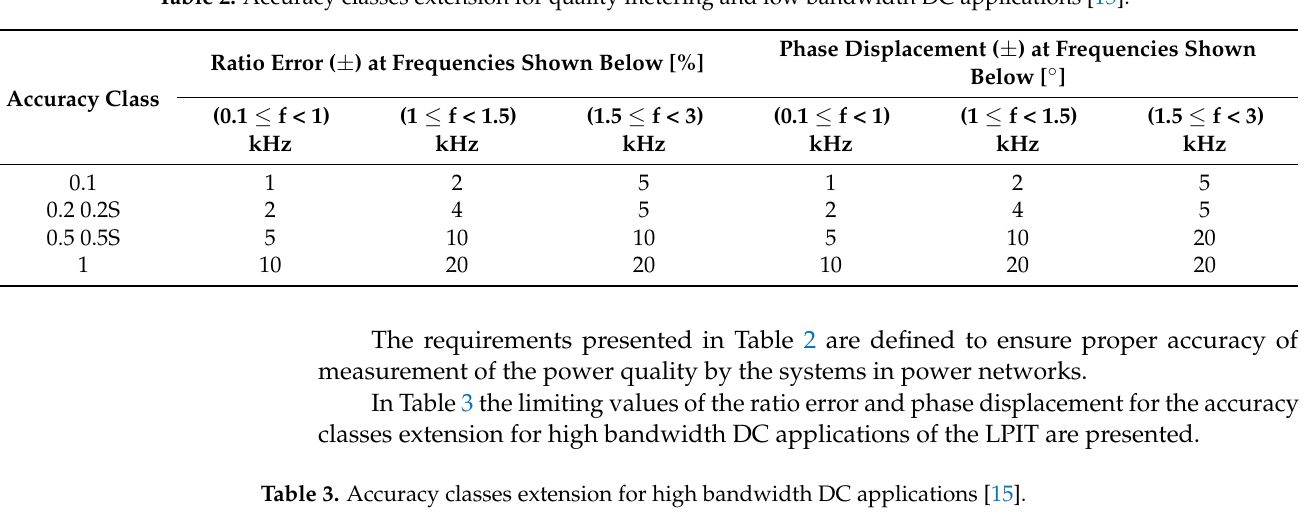
Table 2. Accuracy classes extension for quality metering and low bandwidth DC applications [15].